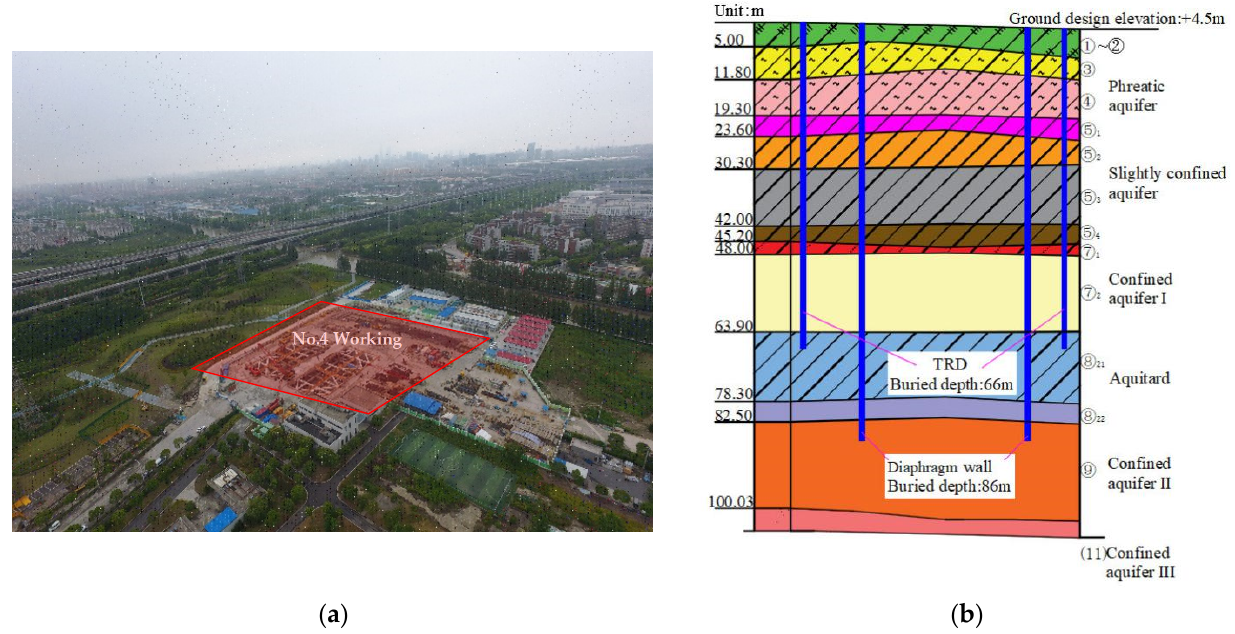
Figure 1. Layout of the No. 4 working shaft, Guangyuan project, Shanghai China: ( a ) No. 4 working shaft; ( b ) Hydrogeological profiles.